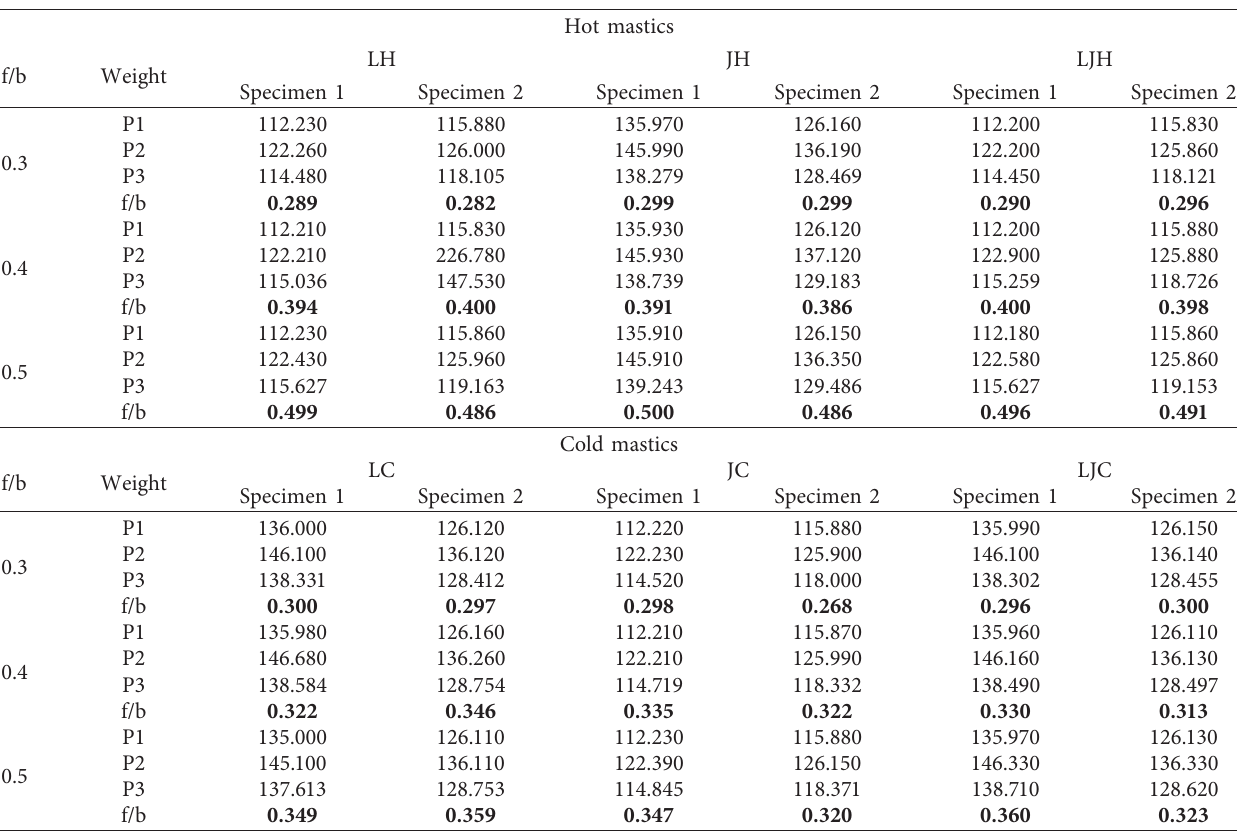
Figure 5: Checking filler content: (a) calibration of the glass test tubes, (b) specimen ready for the centrifuge, (c) centrifuge equipment, and (d) residual Table 5: Filler-to-bitumen ratio results.